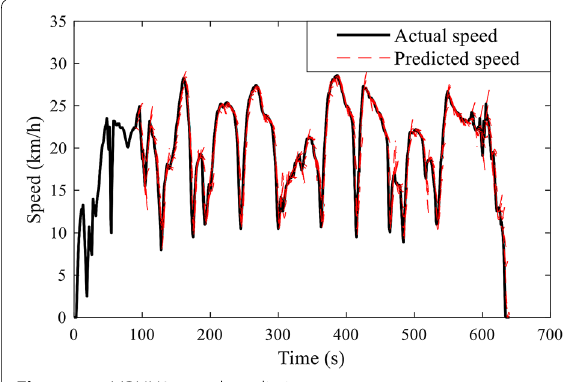
Figure 15 MBNN2 speed prediction